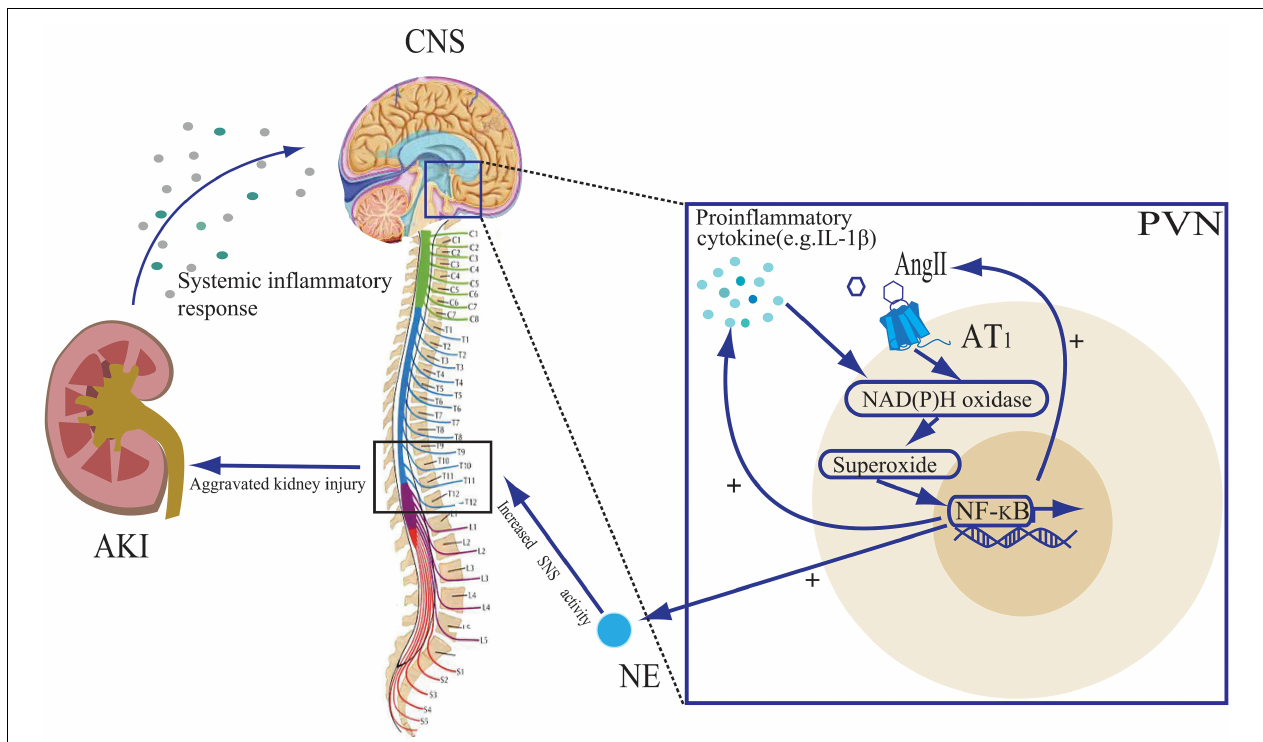
FIGURE 2 | The role of proinflammatory cytokines and angiotensin II (Ang II) in the paraventricular nuclear (PVN) during acute kidney injury (AKI). The systemic inflammatory response to AKI leads to an increase in central nervous system (CNS) pro-inflammatory cytokines. Both Ang II and pro-inflammatory cytokines stimulate NAD(P)H oxidase activity and activate the NF- κ B signaling pathway, leading to further cytokine synthesis and Ang II binding to the Ang II type 1 (AT 1 ) receptor, creating positive feedback loops. The activation of the NF- κ B signaling pathway also leads to an increase in norepinephrine (NE) release, promoting sympathetic nervous system (SNS) activity, further exacerbating kidney